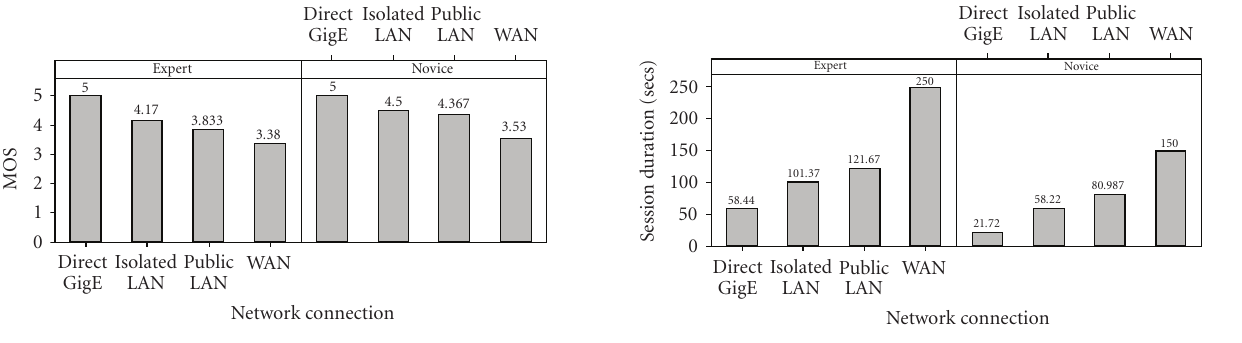
Figure 9: Session duration ( T ) comparison for varying ψ net condi-